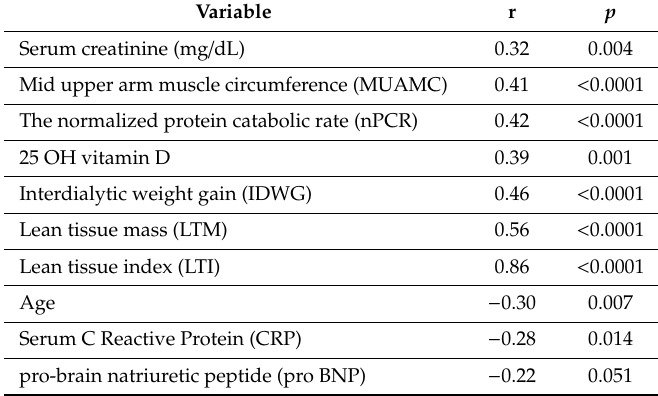
Table 2. Univariate correlations of baseline post-dialysis ICF expressed as Spearman’s rank correlation coe ffi